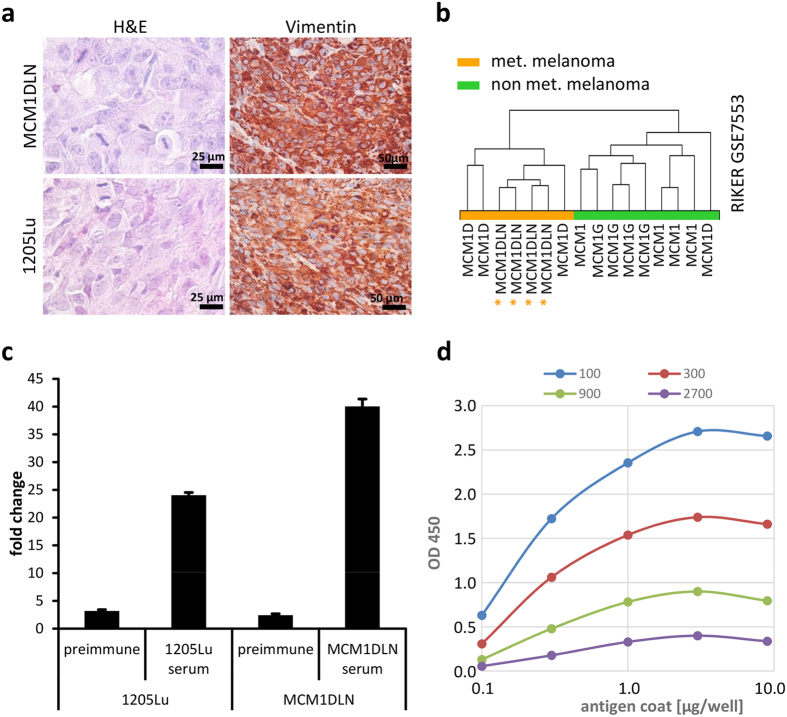
Immunization with metastatic melanoma antigen.(a) Hematoxylin eosin stain (H&E) and human specific vimentin staining (red) of MCM1DLN and 1205Lu xenotransplanted tumours. (b) Unsupervised clustering of MCM1DLN tumours according to expression signature derived from 40 metastatic melanoma lesions versus 16 primary melanomas (fold change >2, p < 0.05) performed by Transcriptome Analysis Console software with no filtering. (c) ELISA coated with 1 μg of tumour lysate (1205Lu and MCM1DLN) incubated with respective serum derived either prior (preimmune) or after immunization. Fold changes relative to negative control are shown. (d) Dose response curve showing the OD450 values for antigen coating concentration versus antibody dilution factor.